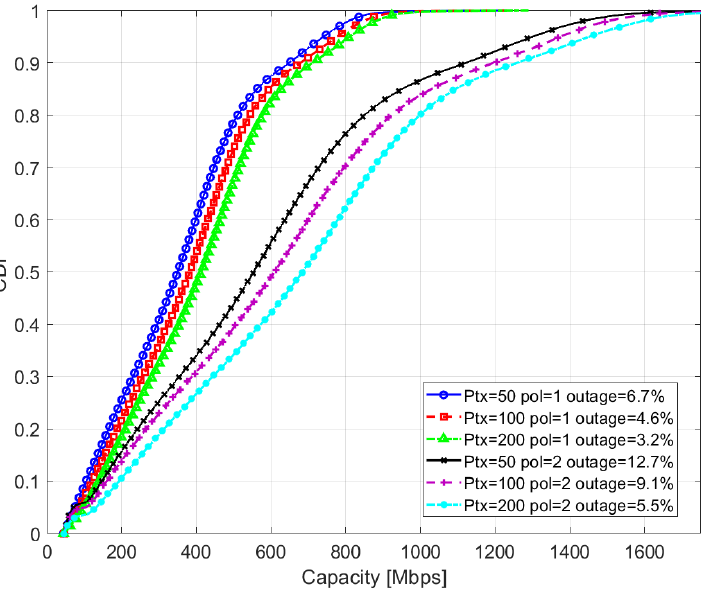
Figure 10. CDF of UT rates for different transmitting powers at the BS, N t = 72 with N ty = 36, N tz = 2, N r = 1, traffic density = 2500 users/km 2 .